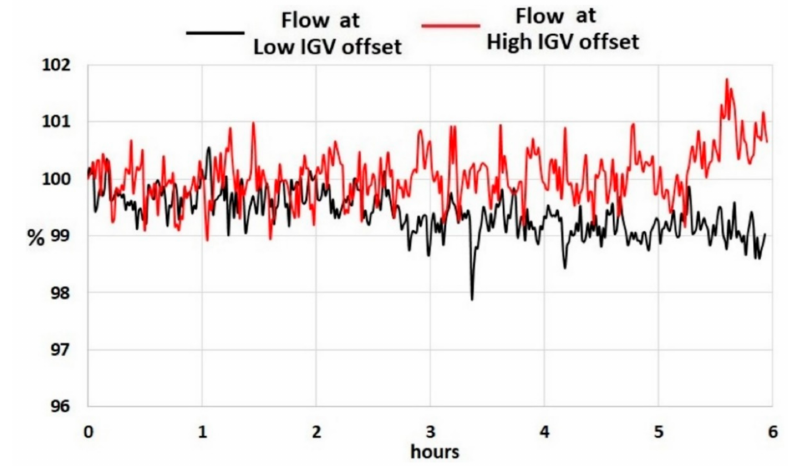
Figure 40. Simulated flow discharged by compressor at low and high IGV offset conditions.